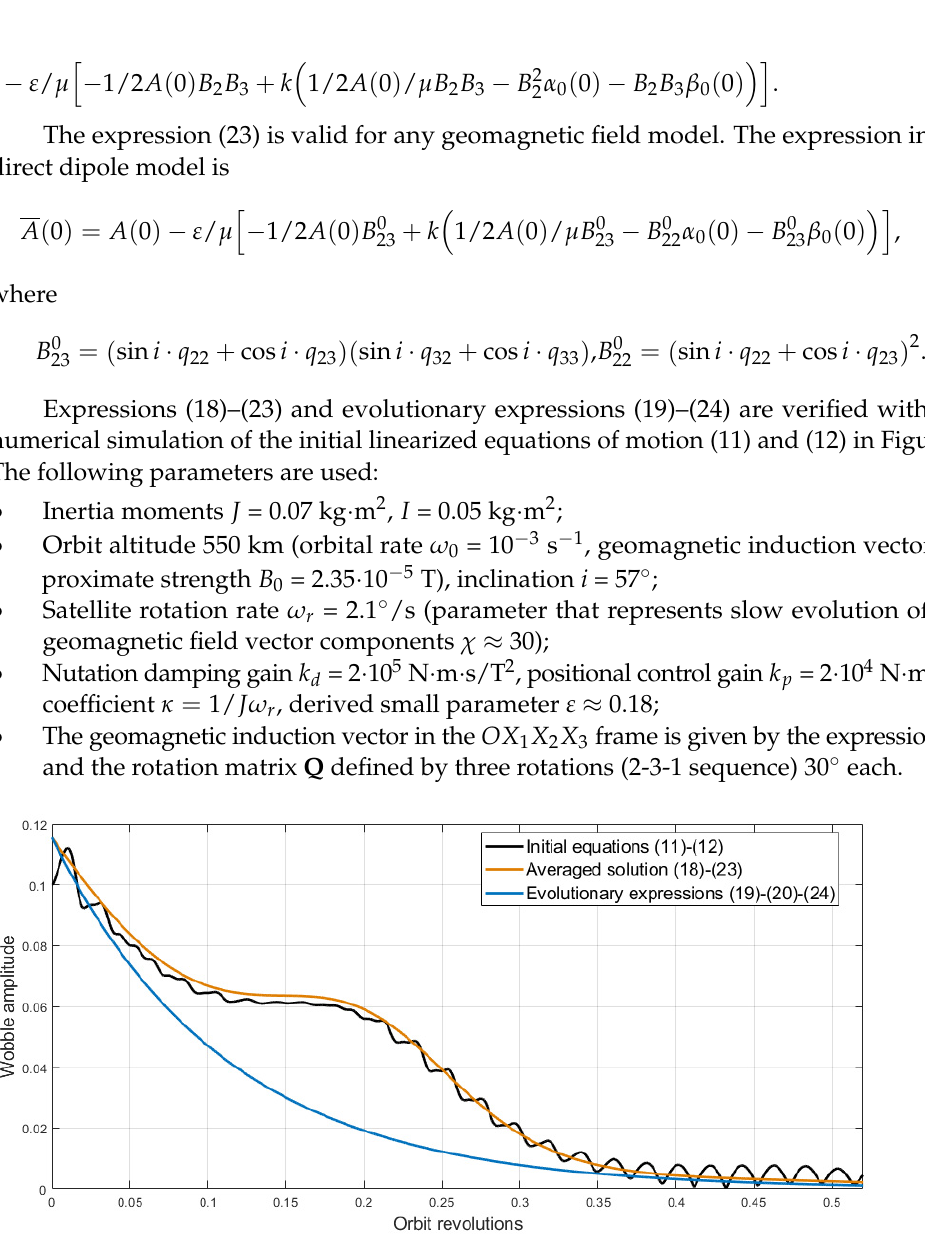
Figure 1. Wobble amplitude. Figure 1 reveals the di ff erence between three solutions in oscillatory behavior. Averaged expressions (18)–(23) quite accurately describe the wobble amplitude time history. Fast oscillations that arise due to the satellite rotation are eliminated from the consideration in the averaged solution. This solution accuracy lowers with time, especially when the amplitude is close to zero and oscillations start to play an important role in the